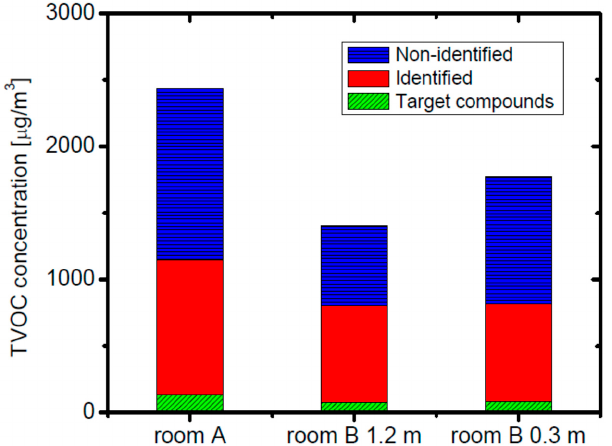
Figure 2. TVOC concentrations and compositions in rooms A and B (at 1.2 m and 0.3 m above the floor) just after the building was